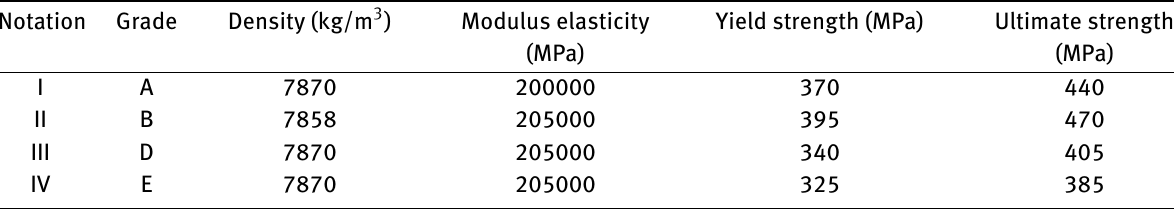
Table 3: Mechanical properties of the proposed materials.